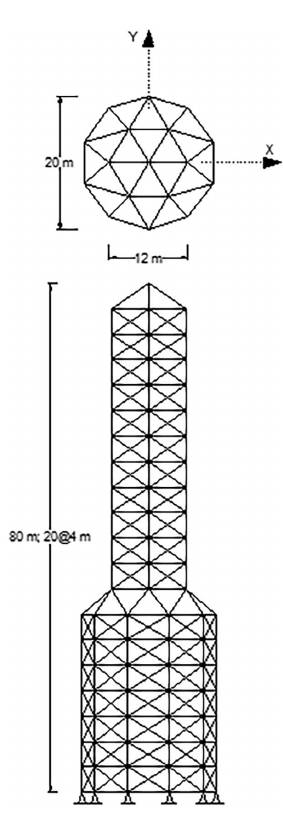
Figure 8. 582-bar tower